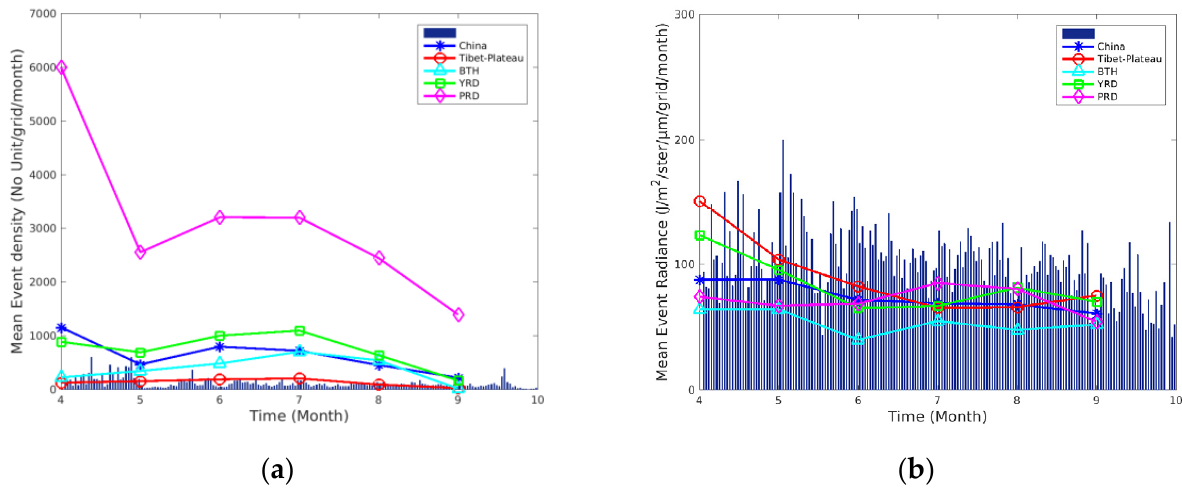
Figure 11. Daily and monthly variations in the LMI Event in China. ( a ) LMI Event density and ( b ) LMI Event radiance.